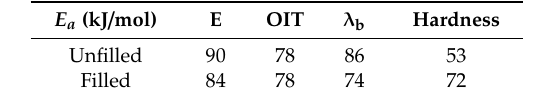
Table 1. Activation energy for all parameters understudied.